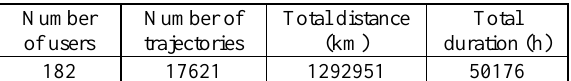
Table 1 . Specification about "Geolife" dataset